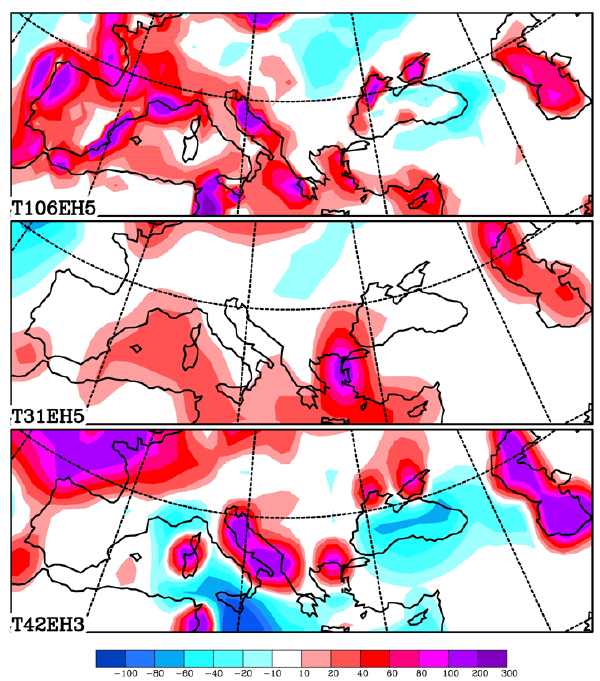
Fig. 6. Annual mean precipitation minus evaporation ( P − E ) in the simulations, difference between LGM and NOW. Contours at ± 0, 10, 20, 40, 60, 80, 100, 200mmseason − 1 . Negative values are blue, positive red.